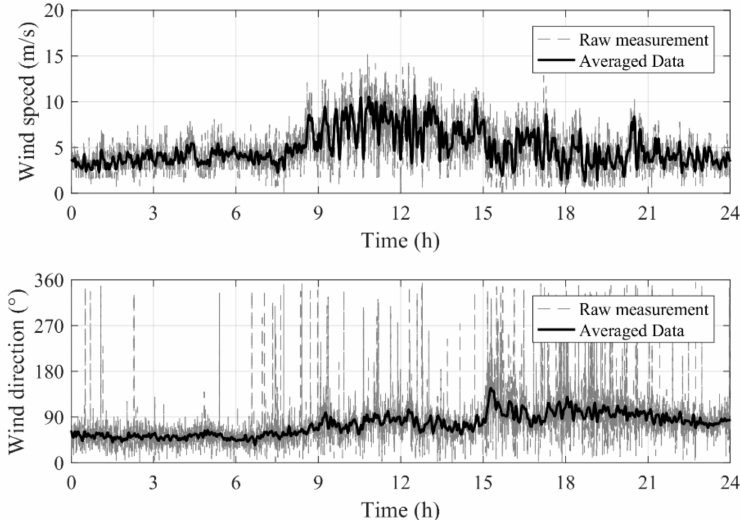
Figure 9. Wind speed and wind direction on 28 August